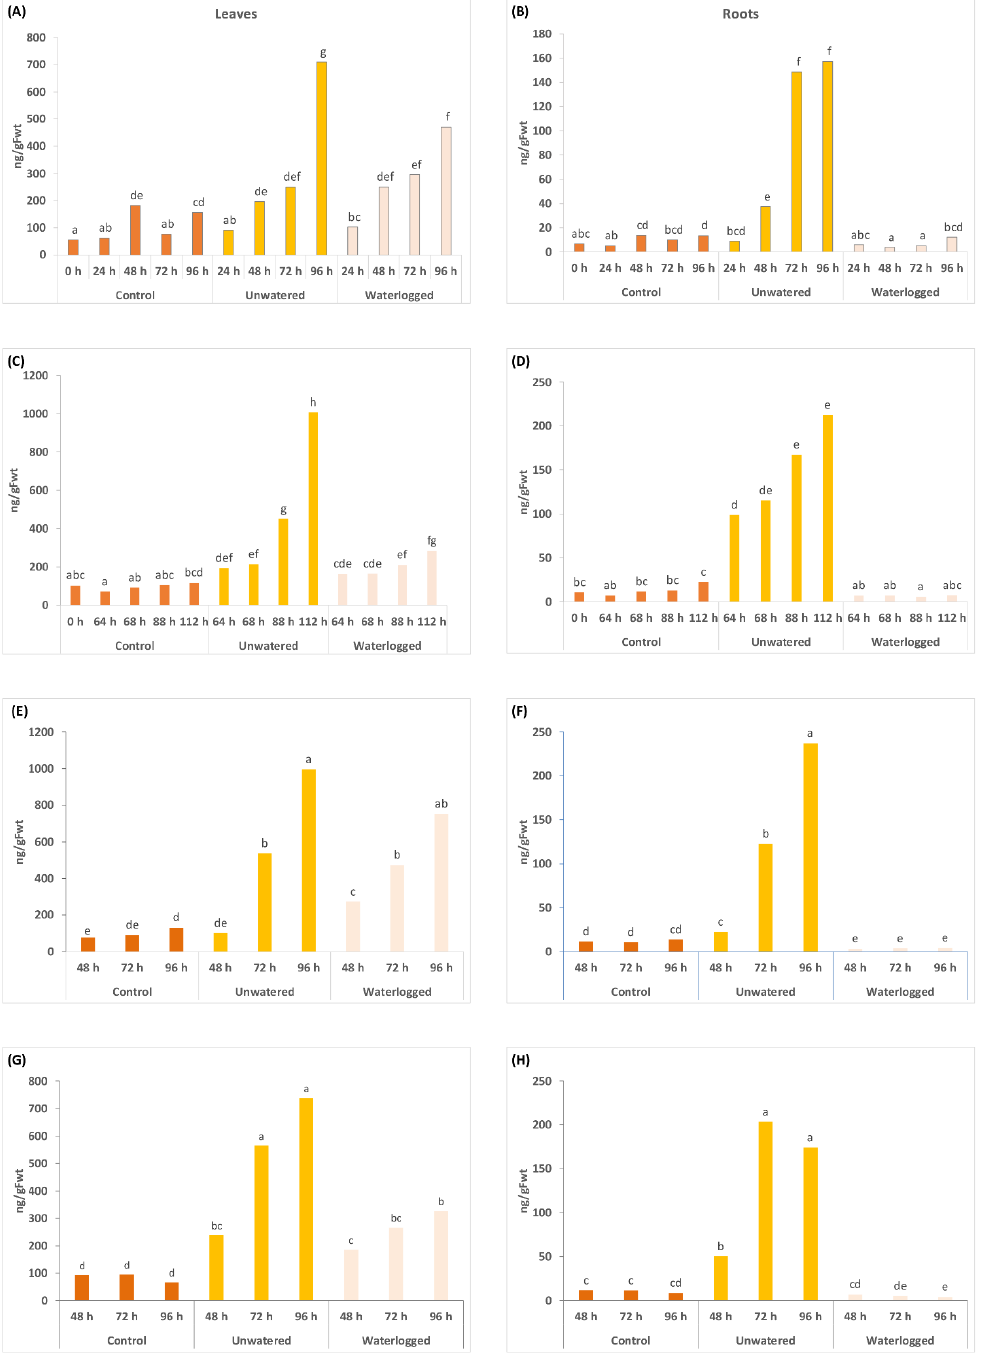
Figure 1. Abscisic acid (ABA) concentrations measured in leaves (left panel) and roots (right panel) at various sample times (in hours, shown in the x-axes) after application of three treatments.